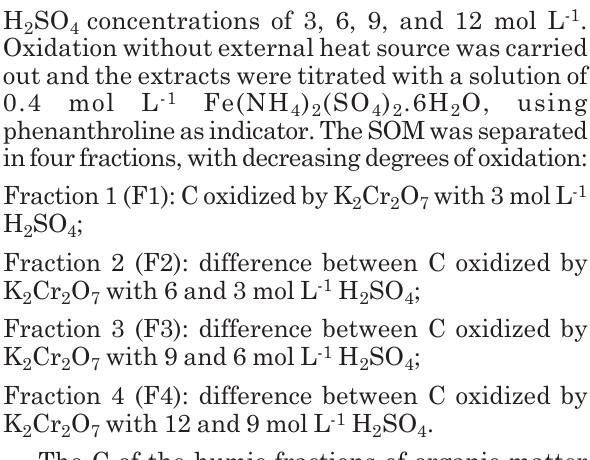
Table 2. Chemical properties of the studied soil